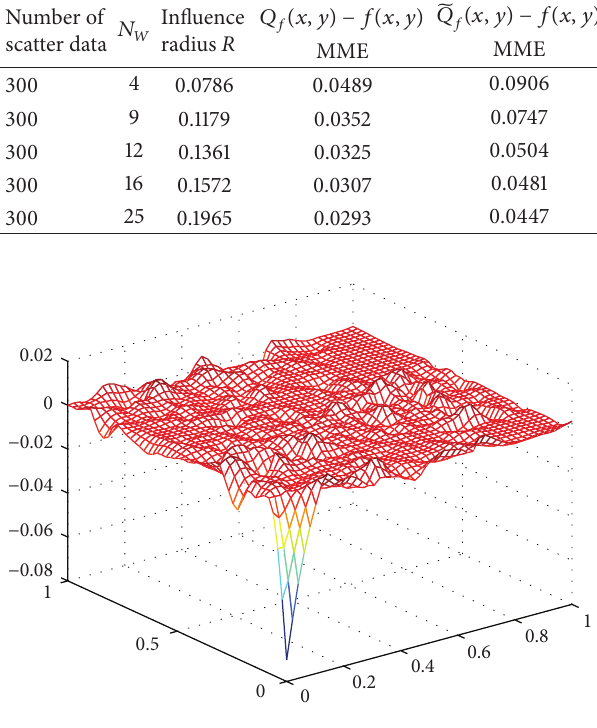
Figure 13: The error graph of WLRBF.